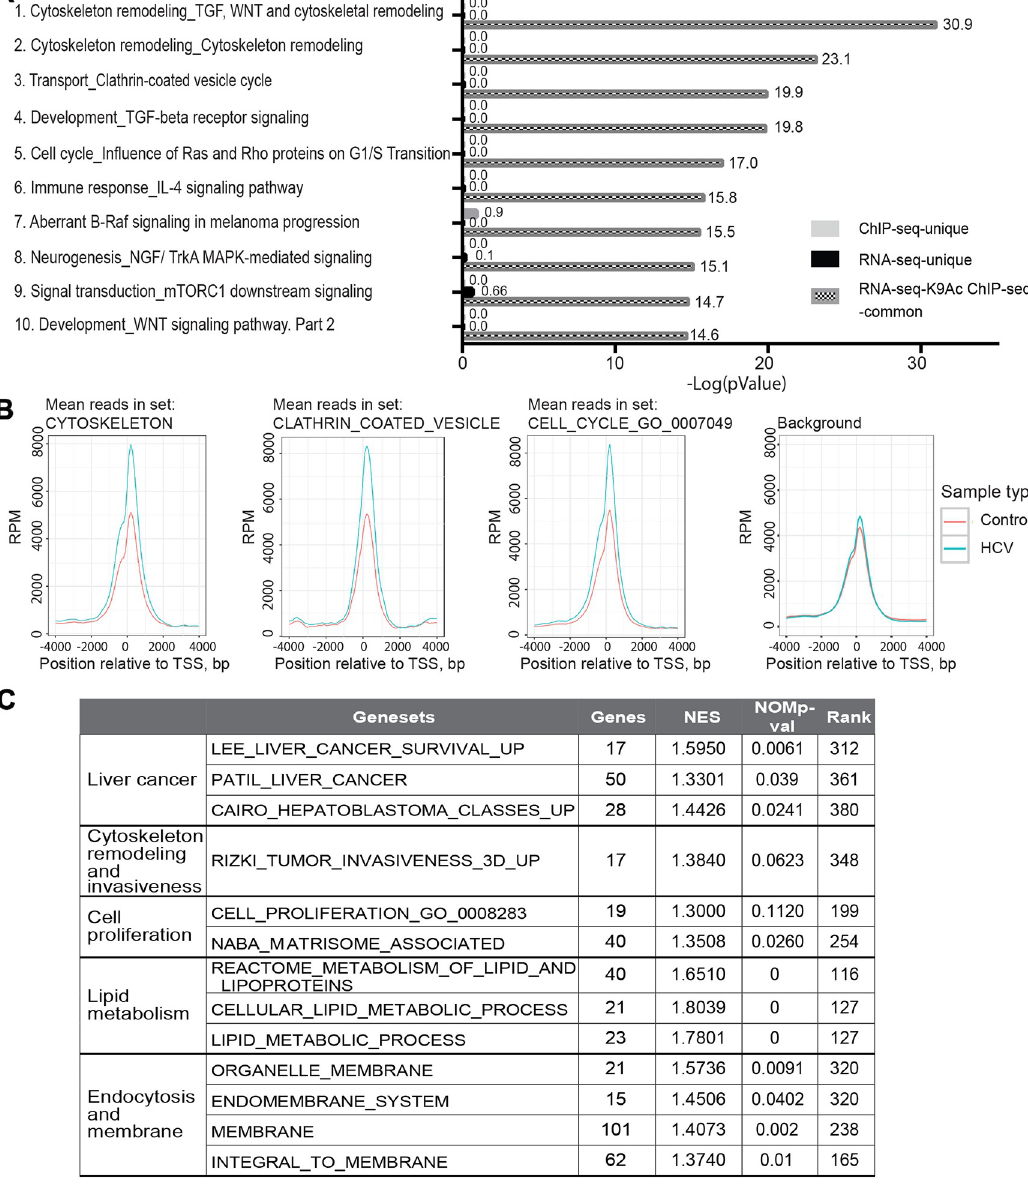
PLOS Genetics | https://doi.org/10.1371/journal.pgen.1008181 June 19,